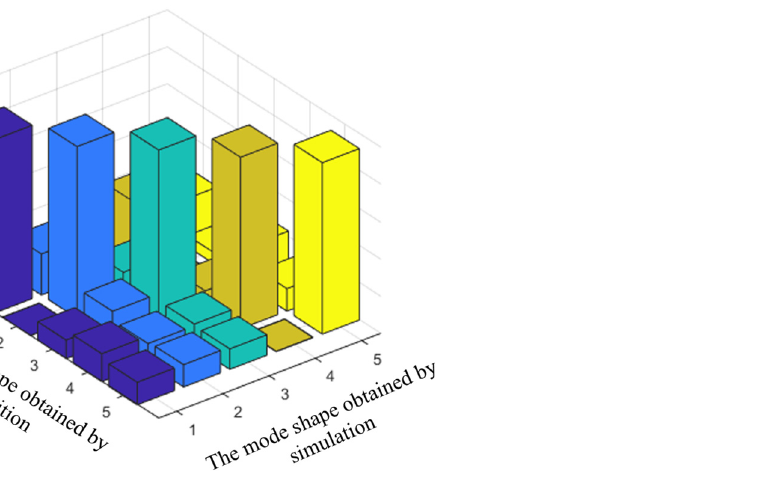
Figure 14. Comparison of the MAC value of the identified mode shape and the theoretical mode shape.